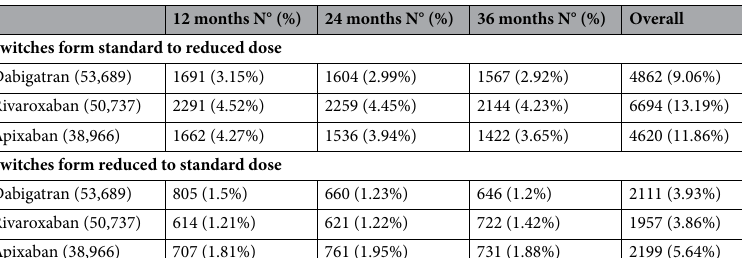
12 months N° (%) 24 months N° (%) 36 months N° (%) Overall Switches form standard to reduced